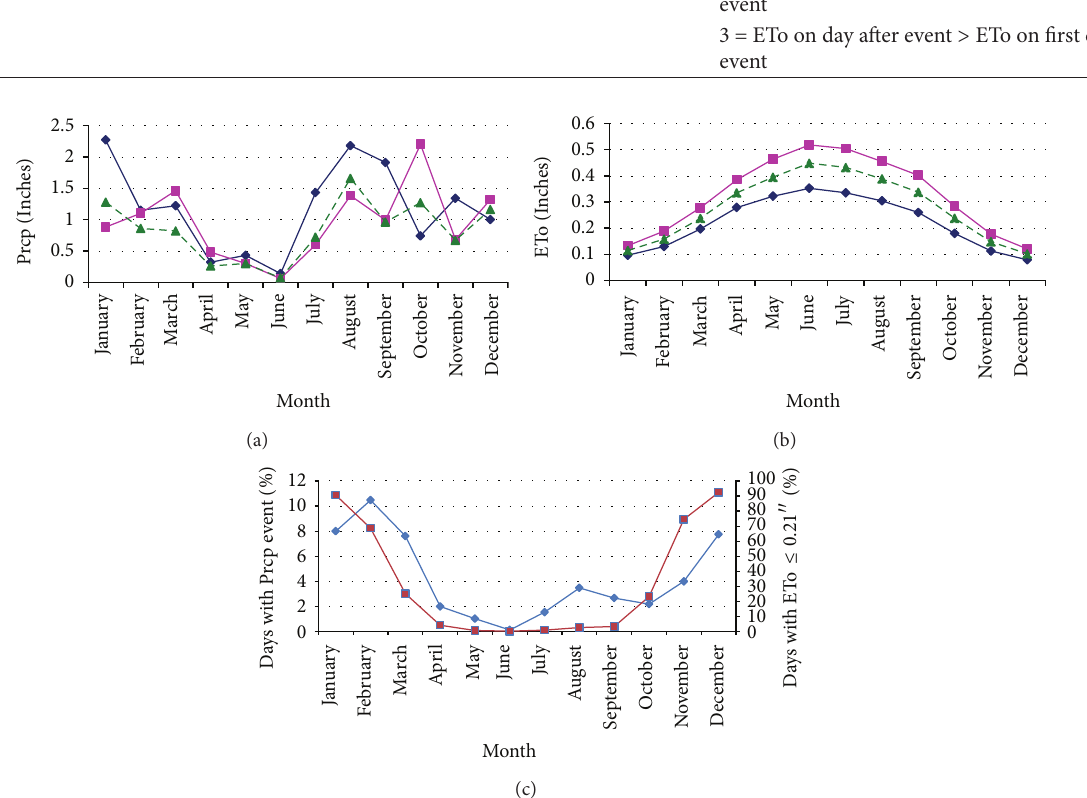
Figure 2: (a) Maximum precipitation (Prcp) volumes by month for each weather station (diamond markers = Thermal-Indio (TI), square markers = Brawley-Calipatria (BC)) and their combined average (dashed line). (b) Comparison of mean evapotranspiration (ETo) by month for each weather station (diamond markers = TI, square markers = BC) and their combined average (dashed line). (c) Monthly comparison of precipitation (Prcp) event days and days having evapotranspiration (ETo) ≤ 0.21 inches based on the BC weather station dataset (1982–2004). RainEvent (Prcp event) = percent of observations having some amount of Prcp, that is, a Prcp event, ETo ≤ 0.21 = percent of observations having ETo ≤ 0.21